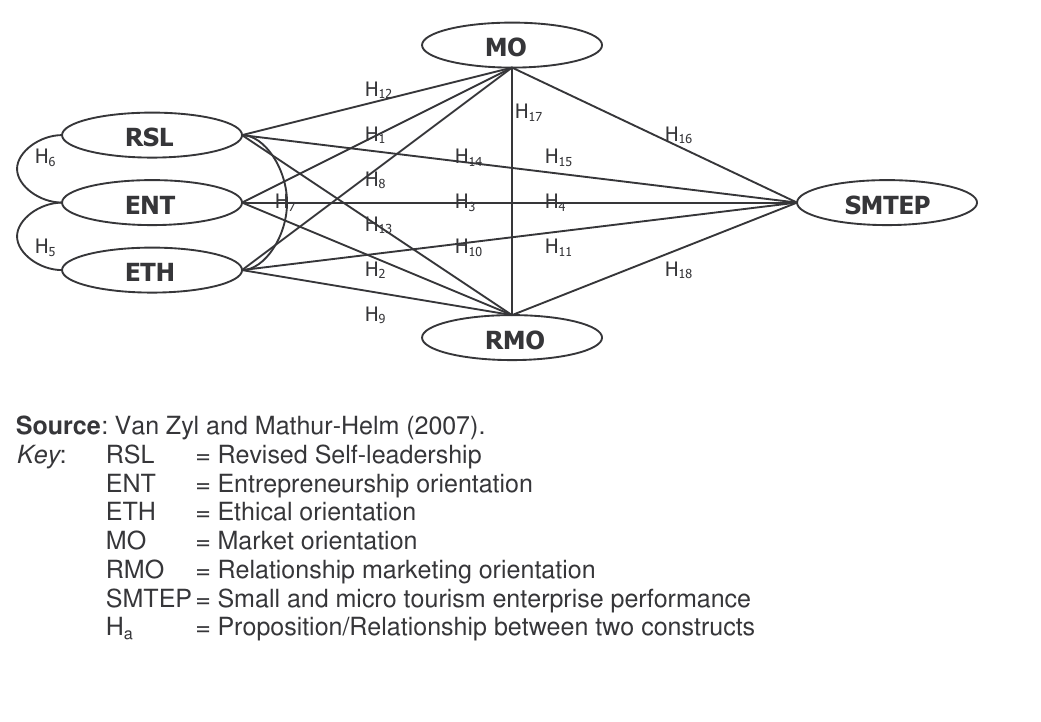
Figure 1: Conceptual measurement